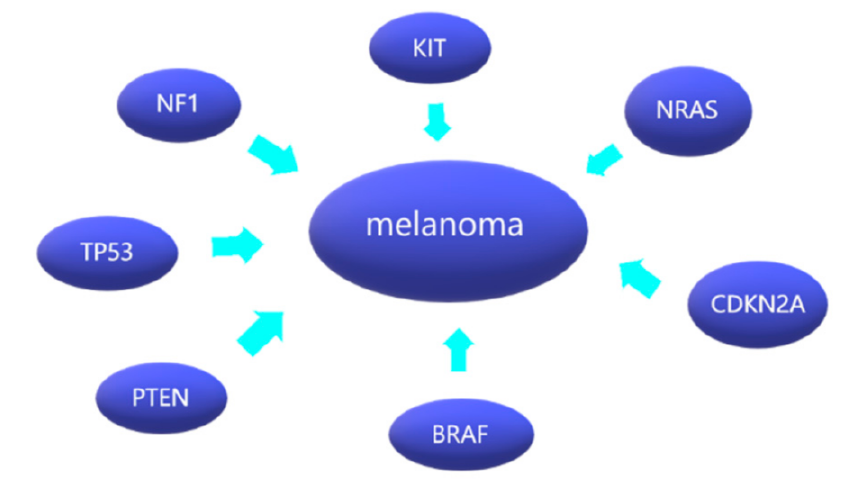
Figure 1. Melanoma and its most common